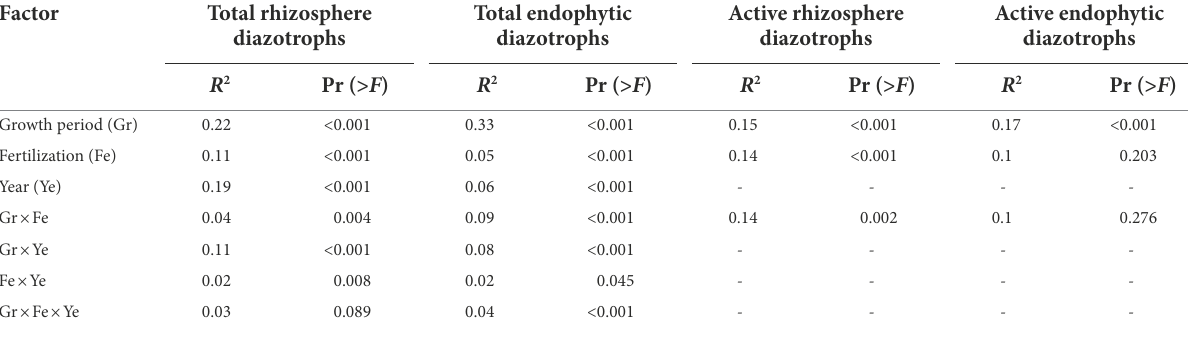
TABLE 1 Effects of growth period, fertilization regime and year on the community composition of rhizosphere and endophytic diazotrophs.